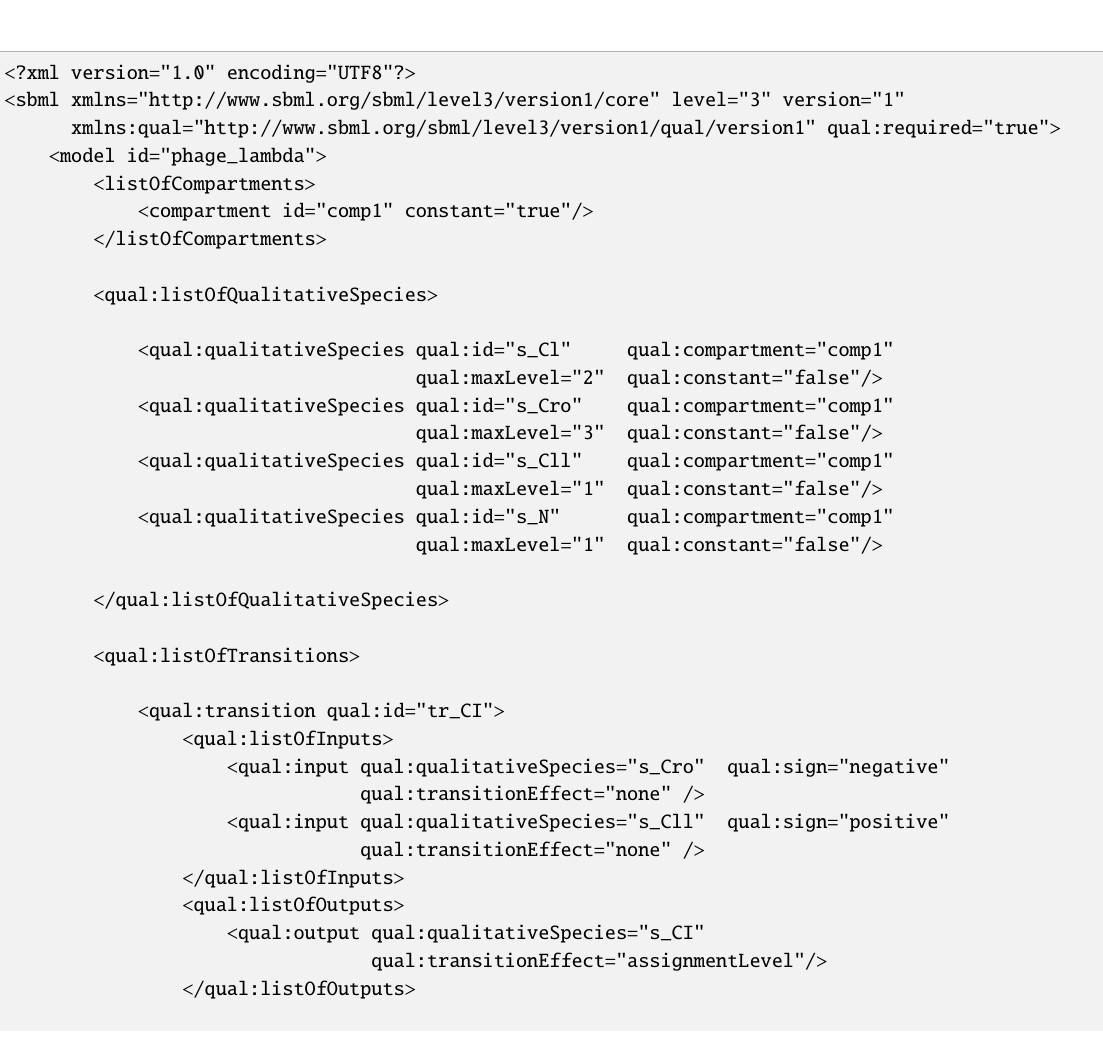
Figure 6: Interaction graph of the four-variable multi-valued model of phage lambda switch (Thieffry and Thomas,